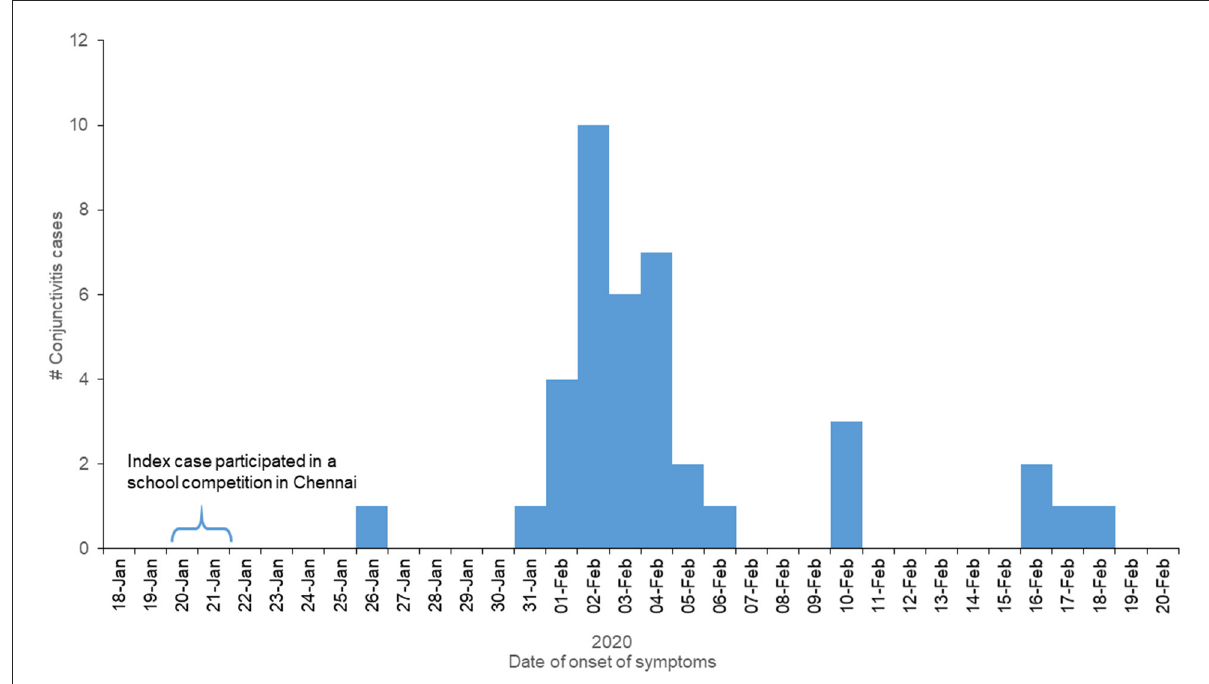
FIGURE1 Acute conjunctivitis cases by date of onset of symptoms among the students and staff of the visually-impaired school, Tamil Nadu, India, Jan–Feb 2020.